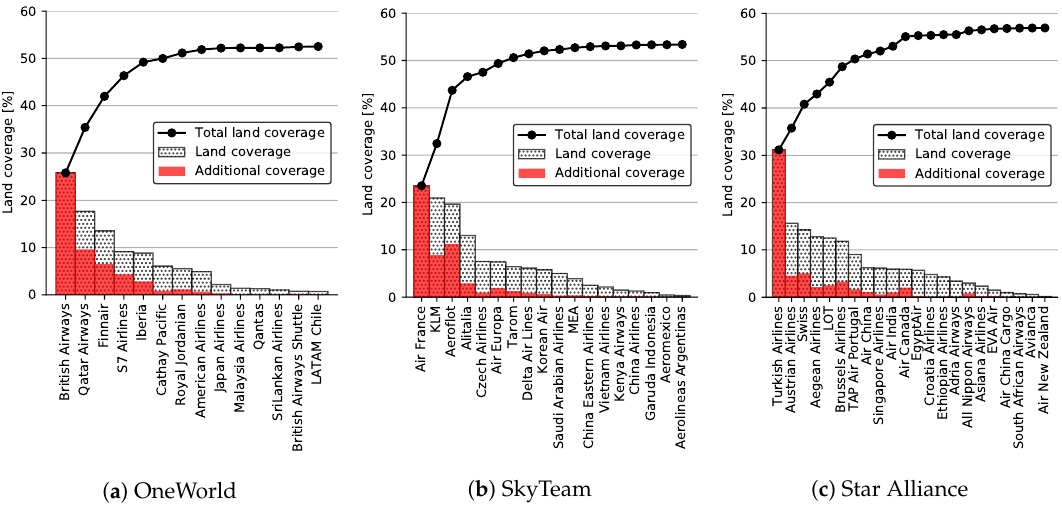
Figure 10. Cumulative land coverage by individual airlines within alliances with Imperx T9040.